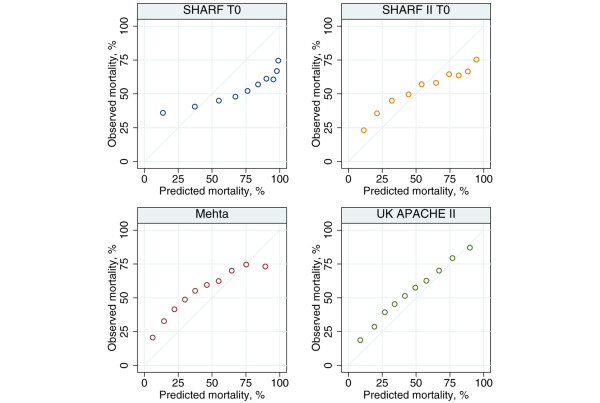
Calibration plots for SHARF T0, SHARF II0, Mehta and UK APACHE II. Observed mortality plotted against deciles of predicted mortality. Diagonal line indicates perfect calibration. APACHE, Acute Physiology and Chronic Health Evaluation; SHARF, Stuivenberg Hospital Acute Renal Failure.